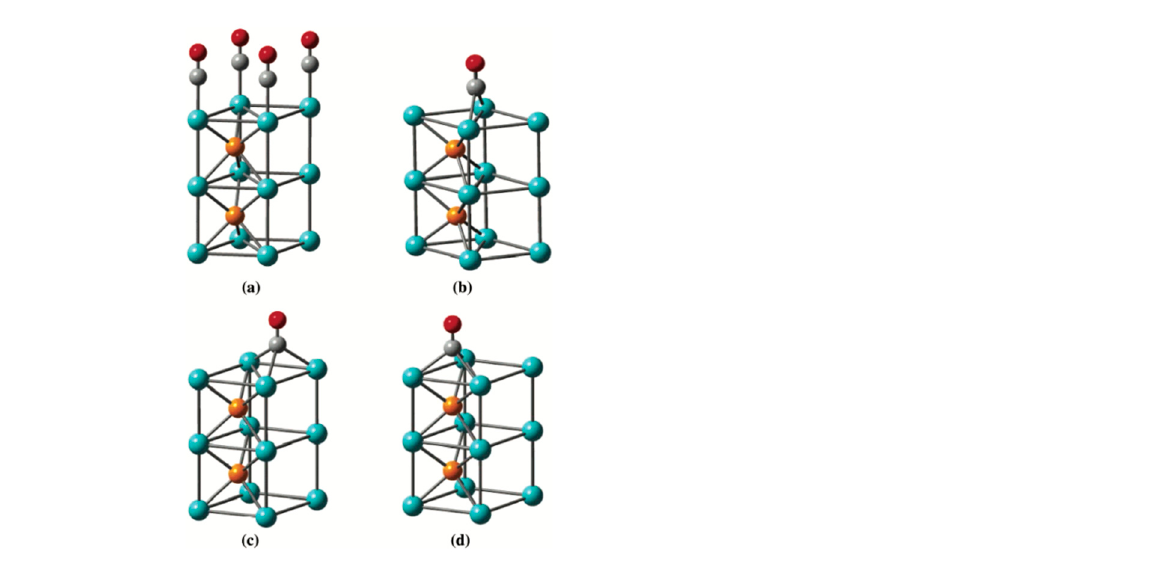
Figure 6. CO chemisorption on MoP-(001)-(1 × 1) surface: ( a ) on-top Mo, ( b ) bridge, ( c ) fcc site, and ( d ) hcp hollow site. Reprinted with permission from Ref. [107]. Copyright 2017 Springer Nature.